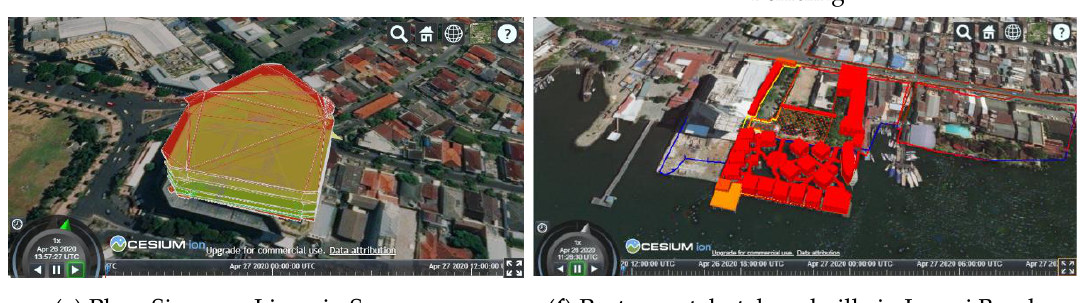
Figure 10. Representations of 3D cadastre case studies in the prototype.